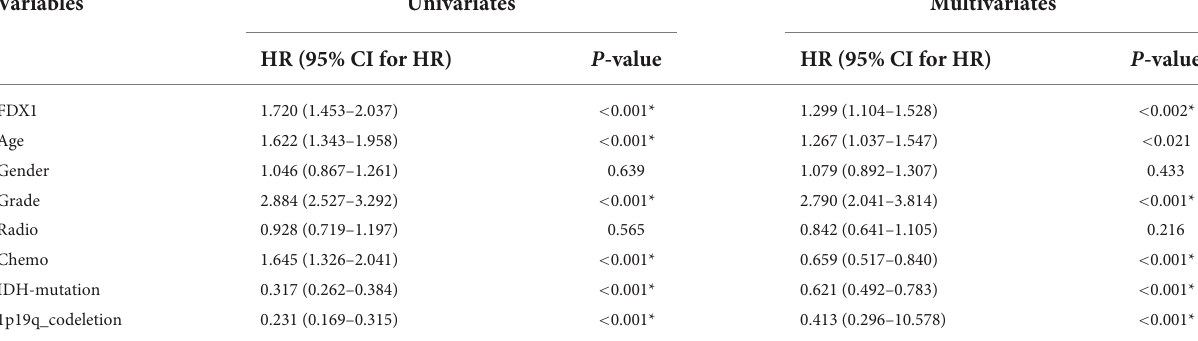
TABLE 1 Cox regression analysis of the clinical variables, and overall survival in CGGA cohorts.